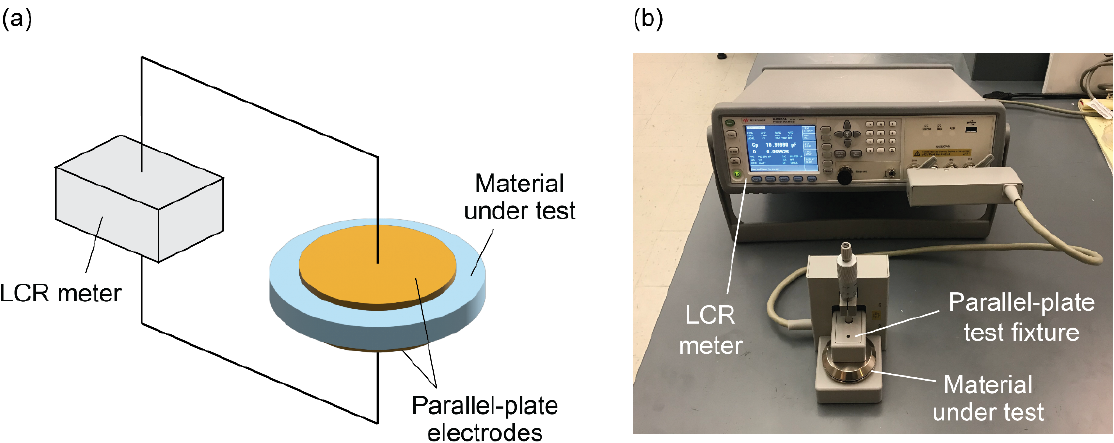
Figure 15. ( a ) Schematic illustration of a sample-filled parallel-plate capacitor connected to an LCR meter. Redrawn from [99] (p. 109); and ( b ) commercially available setup. Adapted from [41] (p. 76). Copyright 2019 YUSUKE MUKAI.